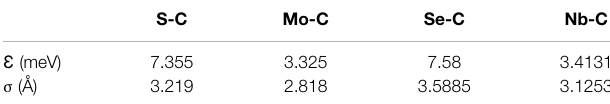
TABLE 2 | LJ parameters for the α -Te/MoS 2 and α -Te/NbSe 2 systems. S-Te